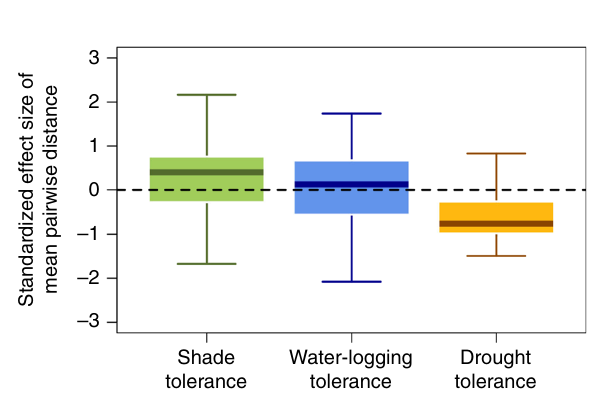
Fig. 2 Environmental tolerance similarity and tree co-occurrence in a natural forest plot. The results from the analyses for 630 20 × 20 m subplots, where a standardized effect size of the mean pairwise distance is on the y -axis and the type of similarity is on the x -axis. Negative standardized effect size values indicate species were more similar in their tolerances than expected given a random expectation and positive values indicate species were more dissimilar than